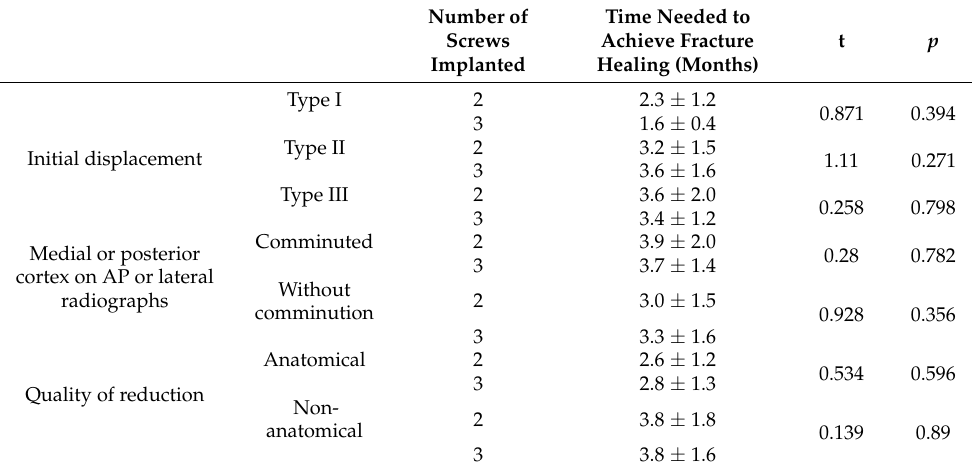
Table 3. Time needed to achieve fracture healing in children treated by 2 or 3 screws according to the initial displacement, comminution of the medial or posterior cortex, and quality of reduction.